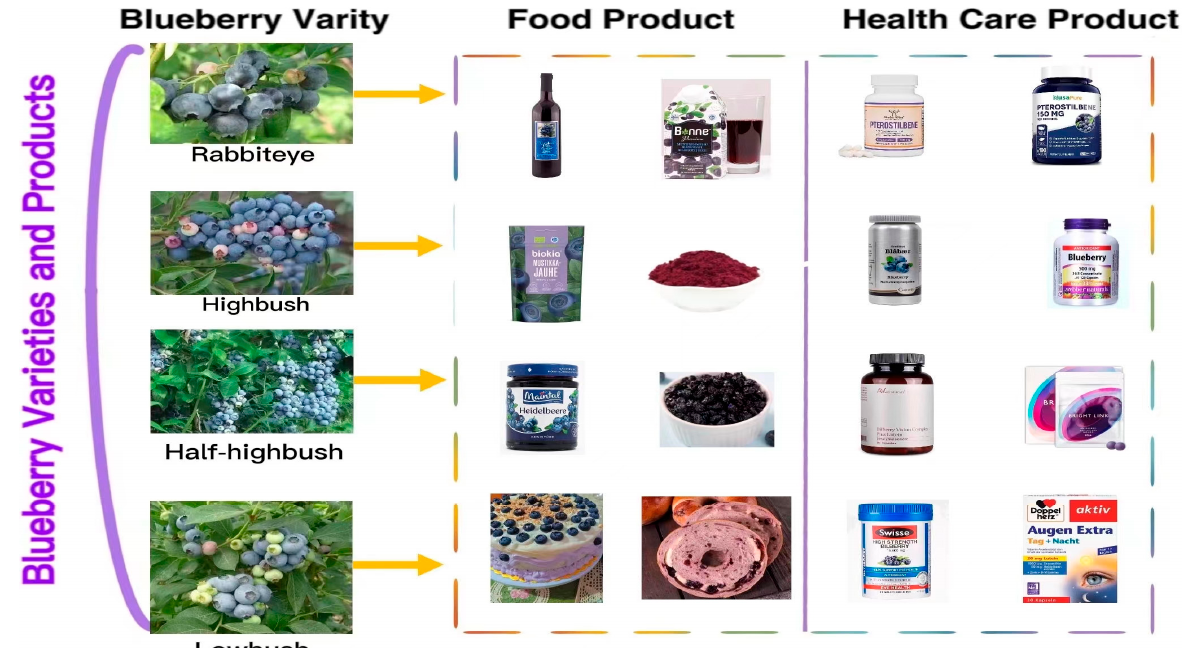
Figure 1. Varieties of blueberries and their products (the pictures of blueberry varieties are from the Fruit Information Center’s wechat public account, the pictures of bread are from the open source website https://pixabay.com accessed on 20 March 2023, and the pictures of food and health products are from the official website of the individual products).